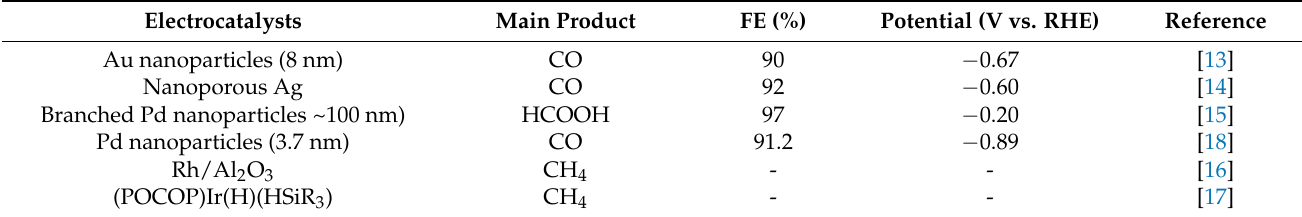
Table 2. Summary of noble metal-based electrocatalysts for CO 2